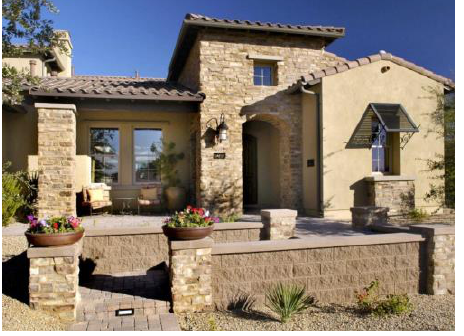
Figure 3. Mediterranean vernacular